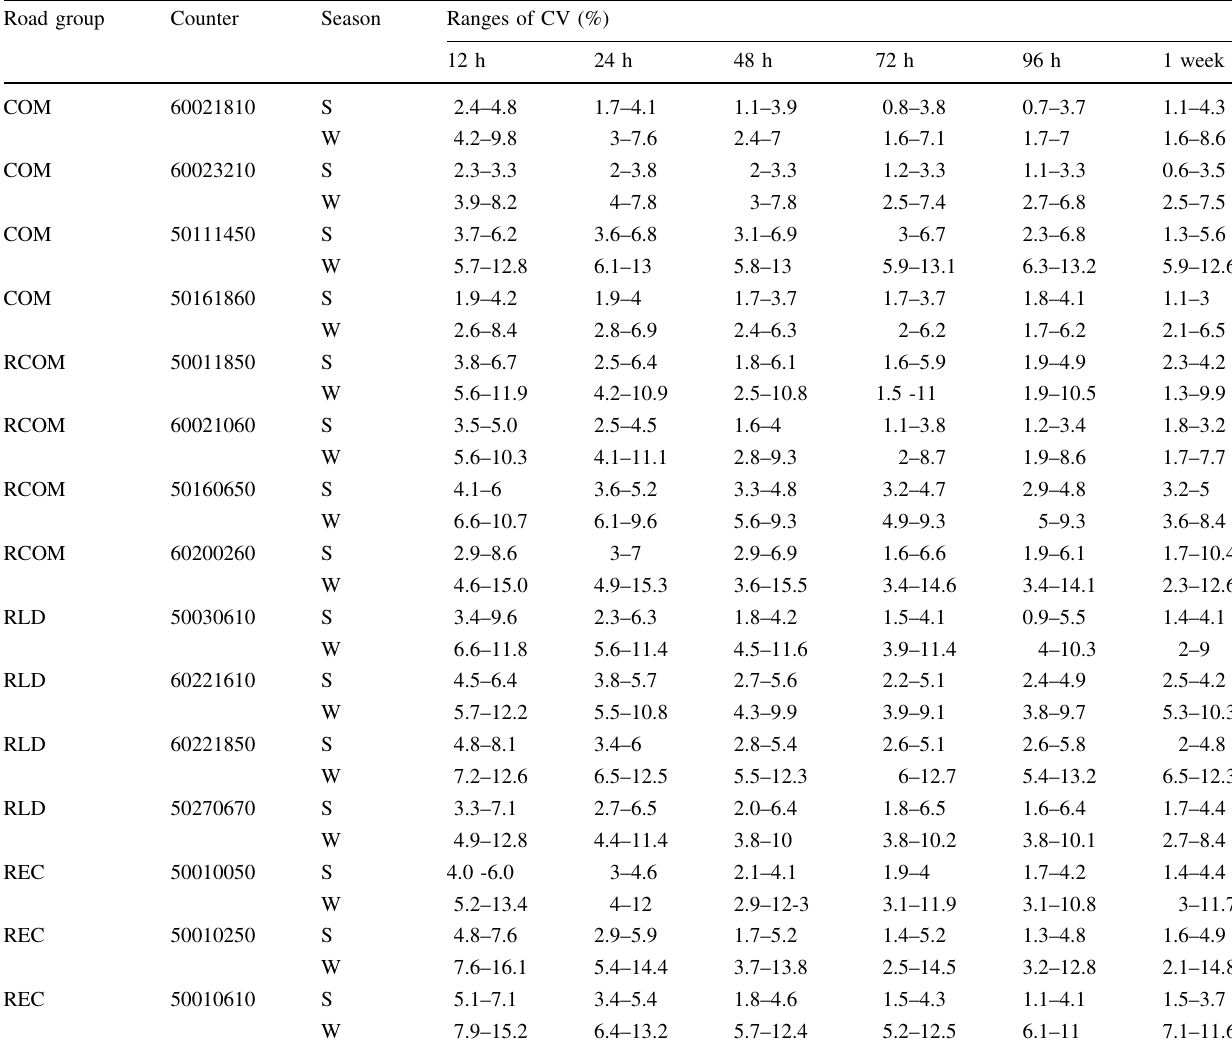
Table 3 Traffic pattern of short-period counts during summer (S) and winter (W) Road group